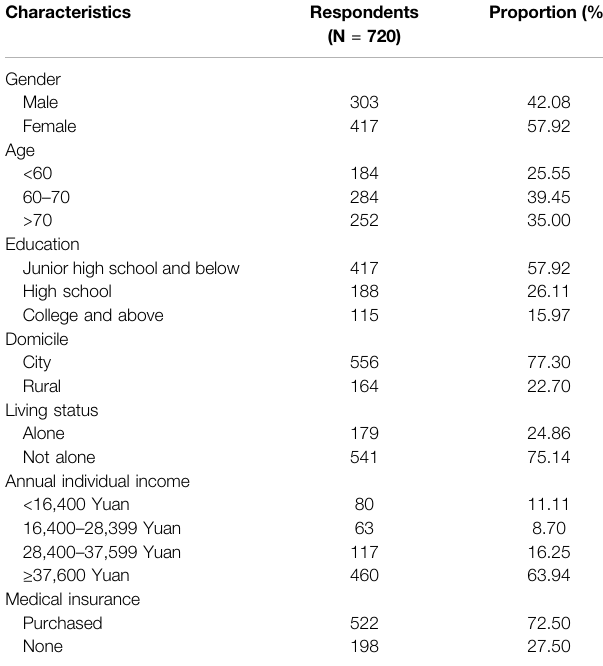
TABLE 2 | Descriptive characteristics of the study